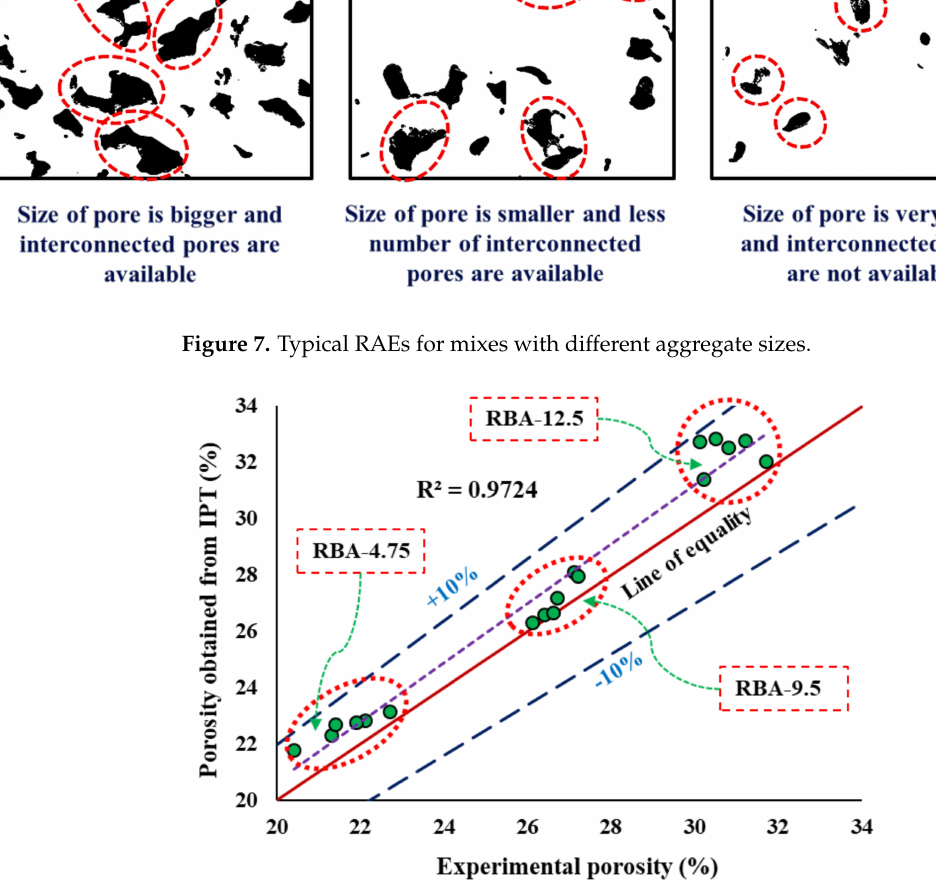
Figure 8. Comparison of experimental porosity with the porosity obtained from